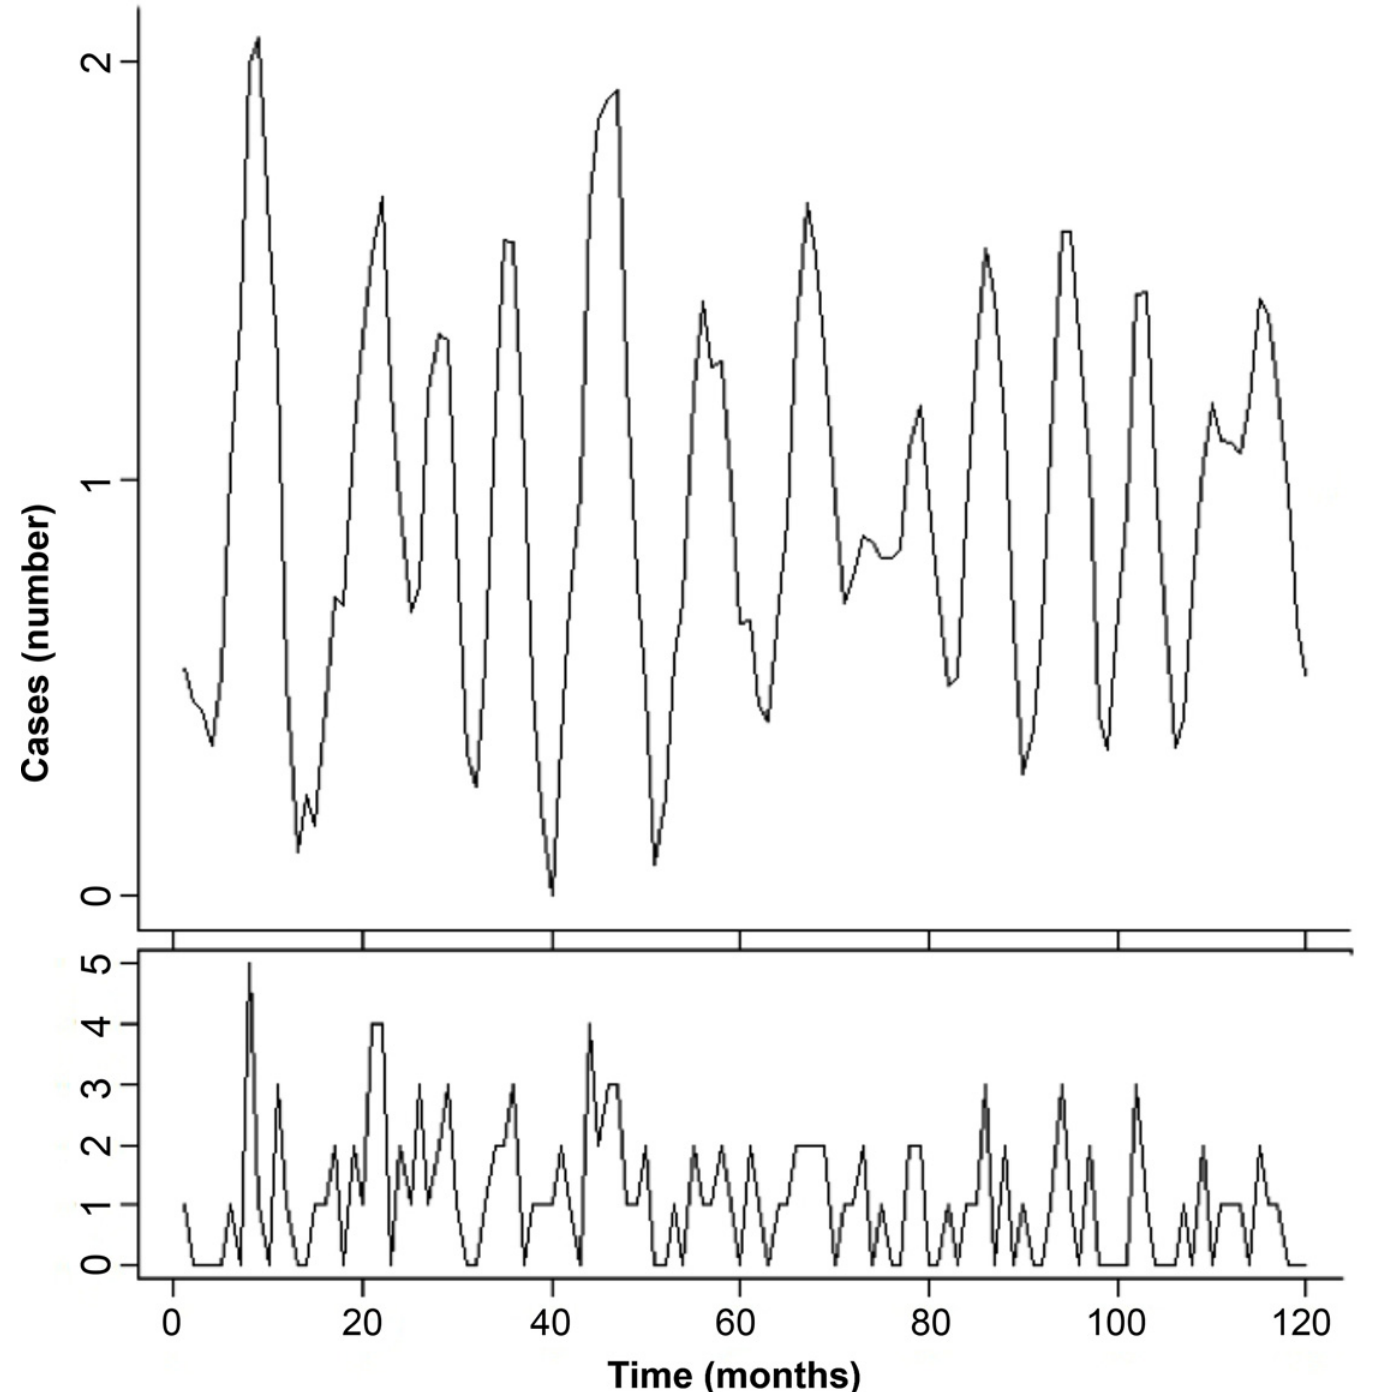
Fig 2. Time series of nontuberculous mycobacterial lymphadenitis and skin and soft tissue infections combined over the study period. The lower plot shows the raw data; the upper plot shows the 3 rd level denoised data. Denoising was performed using a discrete wavelet transform with Daubechies length 6 wavelet